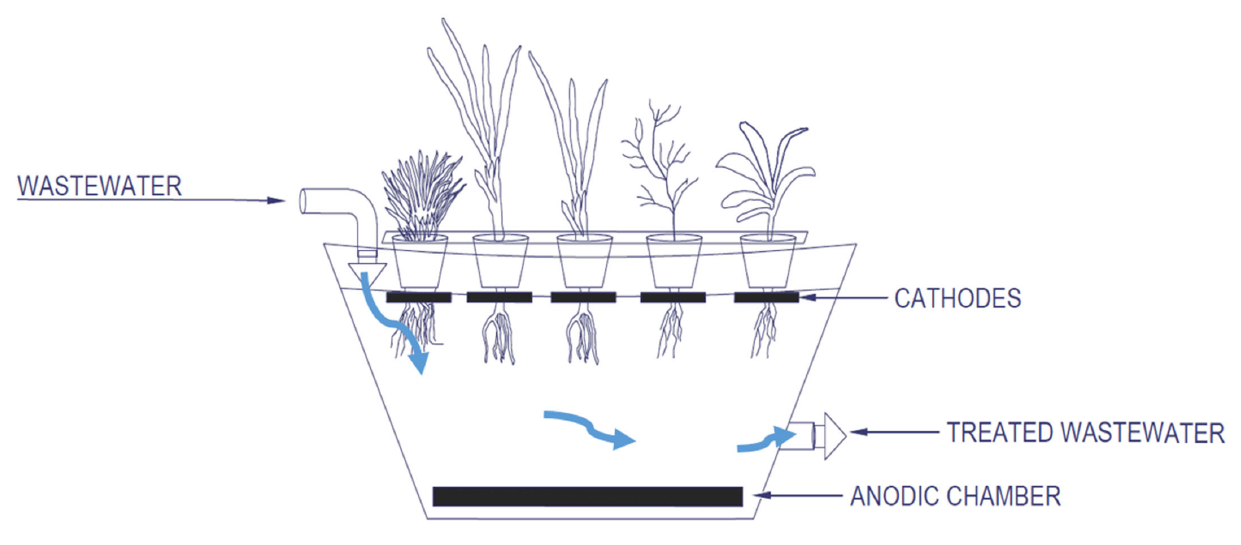
Figure 7. Representation of the floating treatment wetland ‐ MFC (FTW ‐ MFC) ( adapted from Colares et al., (2021) [77]).